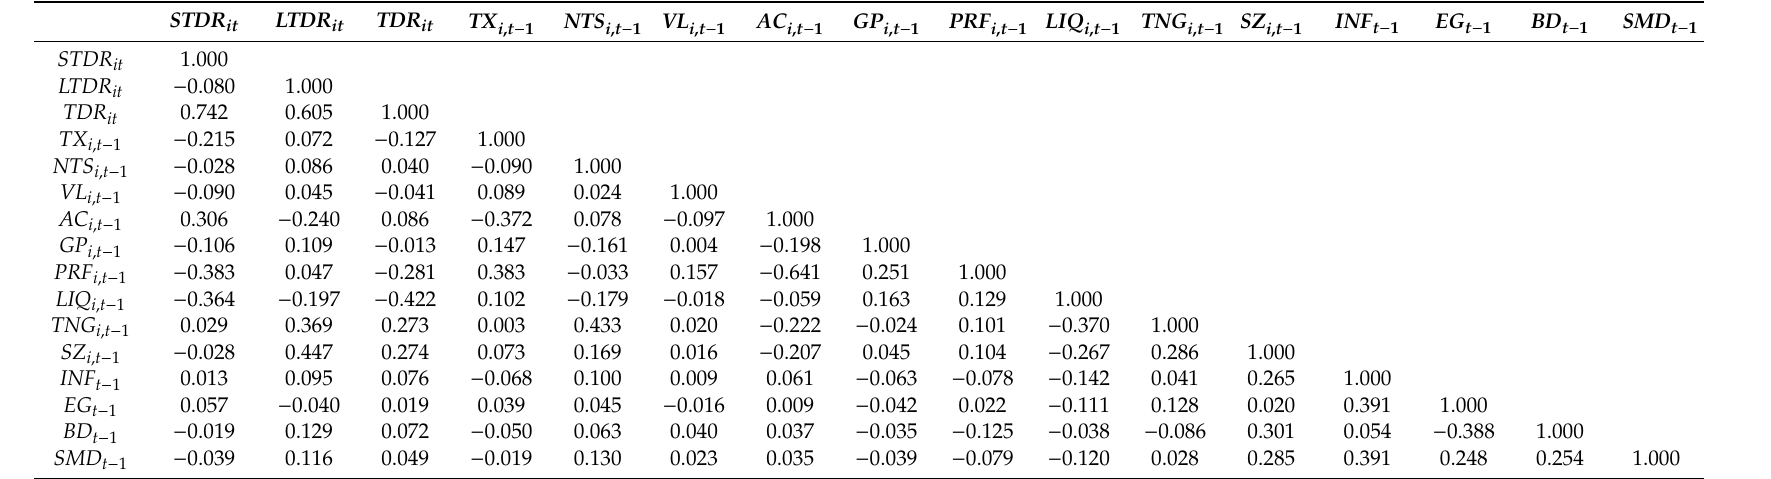
Table 4. Pair-wise Correlation (Highly Competitive Firms).